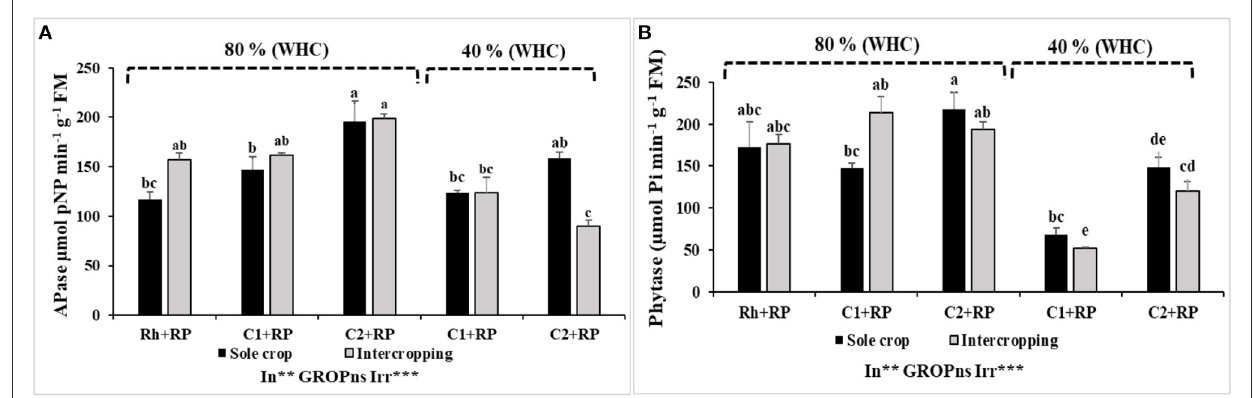
FIGURE7 Faba bean nodules APase activity (A) and nodules phytase activity (B) . Plants were grown as a sole crop or intercropped under water sufficiency and P limitation (80% WHC, RP) vs. combined water deficit and P limitation (40% WHC, RP) and inoculated with two rhizobacterial consortia (C1 and C2) containing rhizobia and two PGPRs. The positive controls were supplemented with 125 µ mol/l of KH 2 PO 4 and 46 mg/l of KNO 3 (control). The negative controls received RP and were inoculated with the rhizobia only (Rh + RP). Each value represents the mean ± standard error (SE) of three replicates (In, inoculation; GROP, type of cropping; Irr, irrigation). Values with different letters are significantly different at 0.05 level of probability by Student-Newman-Keuls. * Represent the significance level of treatments.